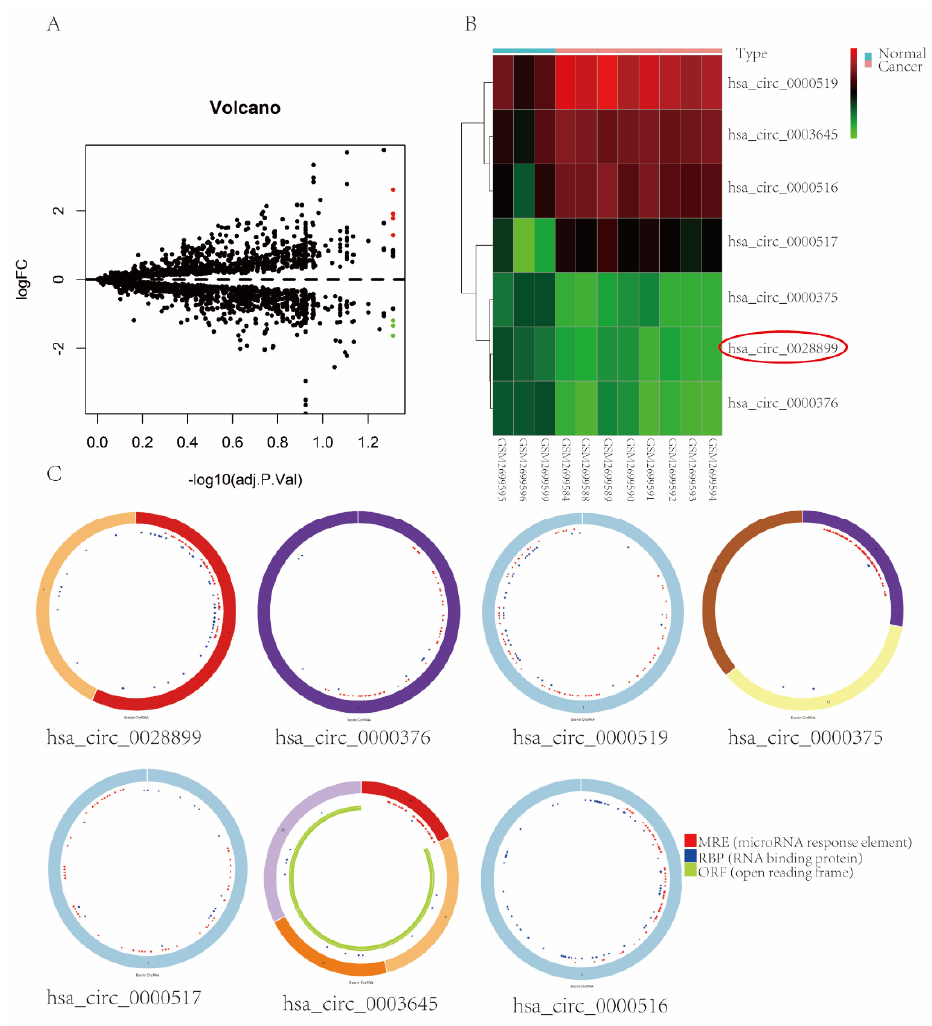
Figure 1. Expression profiles of seven DECs in GEO datasets and their structures. ( A ) Volcano plot of DECs. ( B ) Heatmap of DECs in BC. ( C ) Basic structure and characteristics of seven DECs predicted by the CSCD database.